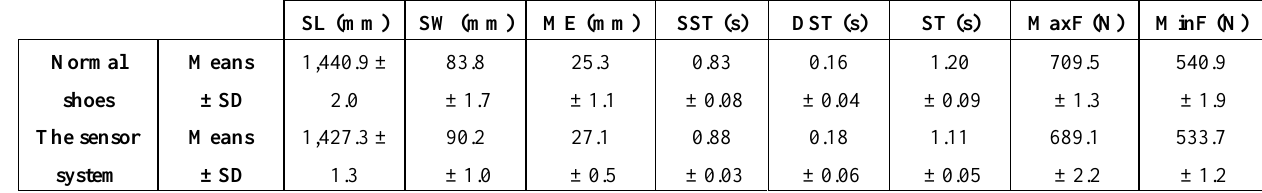
Table 1. The mean and standard deviation of the gait parameters including stride length (SL), stride width (SW), maximum lateral foot excursion (ME), single stance time (SST), double stance time (DST), stride time (ST), maximum GRF (MaxF) and minimum GRF (MinF) for all subjects (p-values <